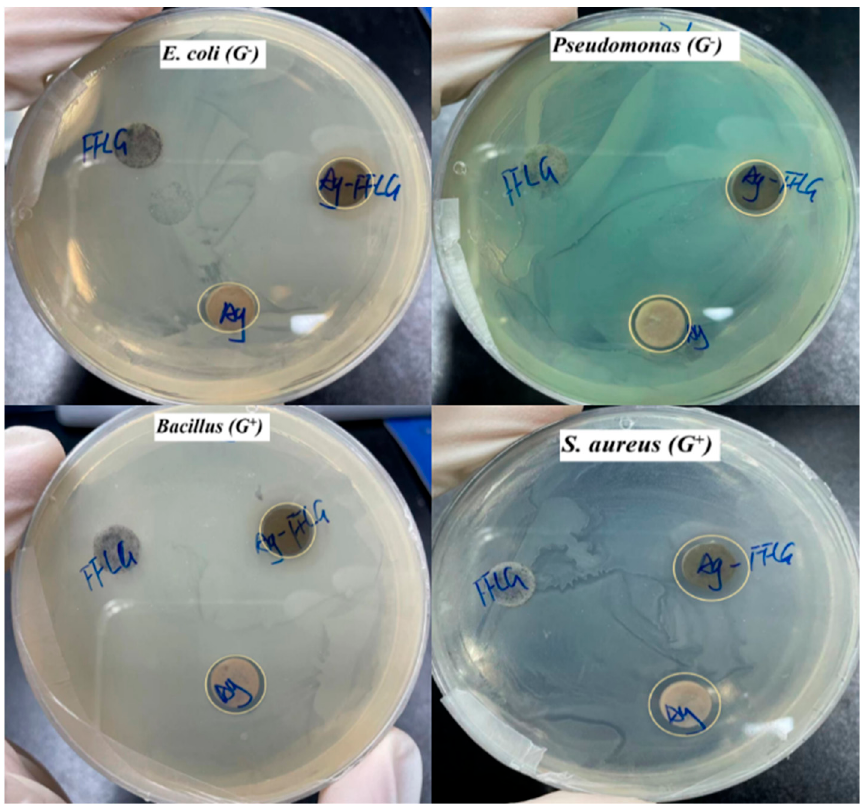
Figure 10. Antibacterial activity test of the prepared FFG, Ag–salt, and Ag–FFG against Gram-positive and Gram-negative bacteria.